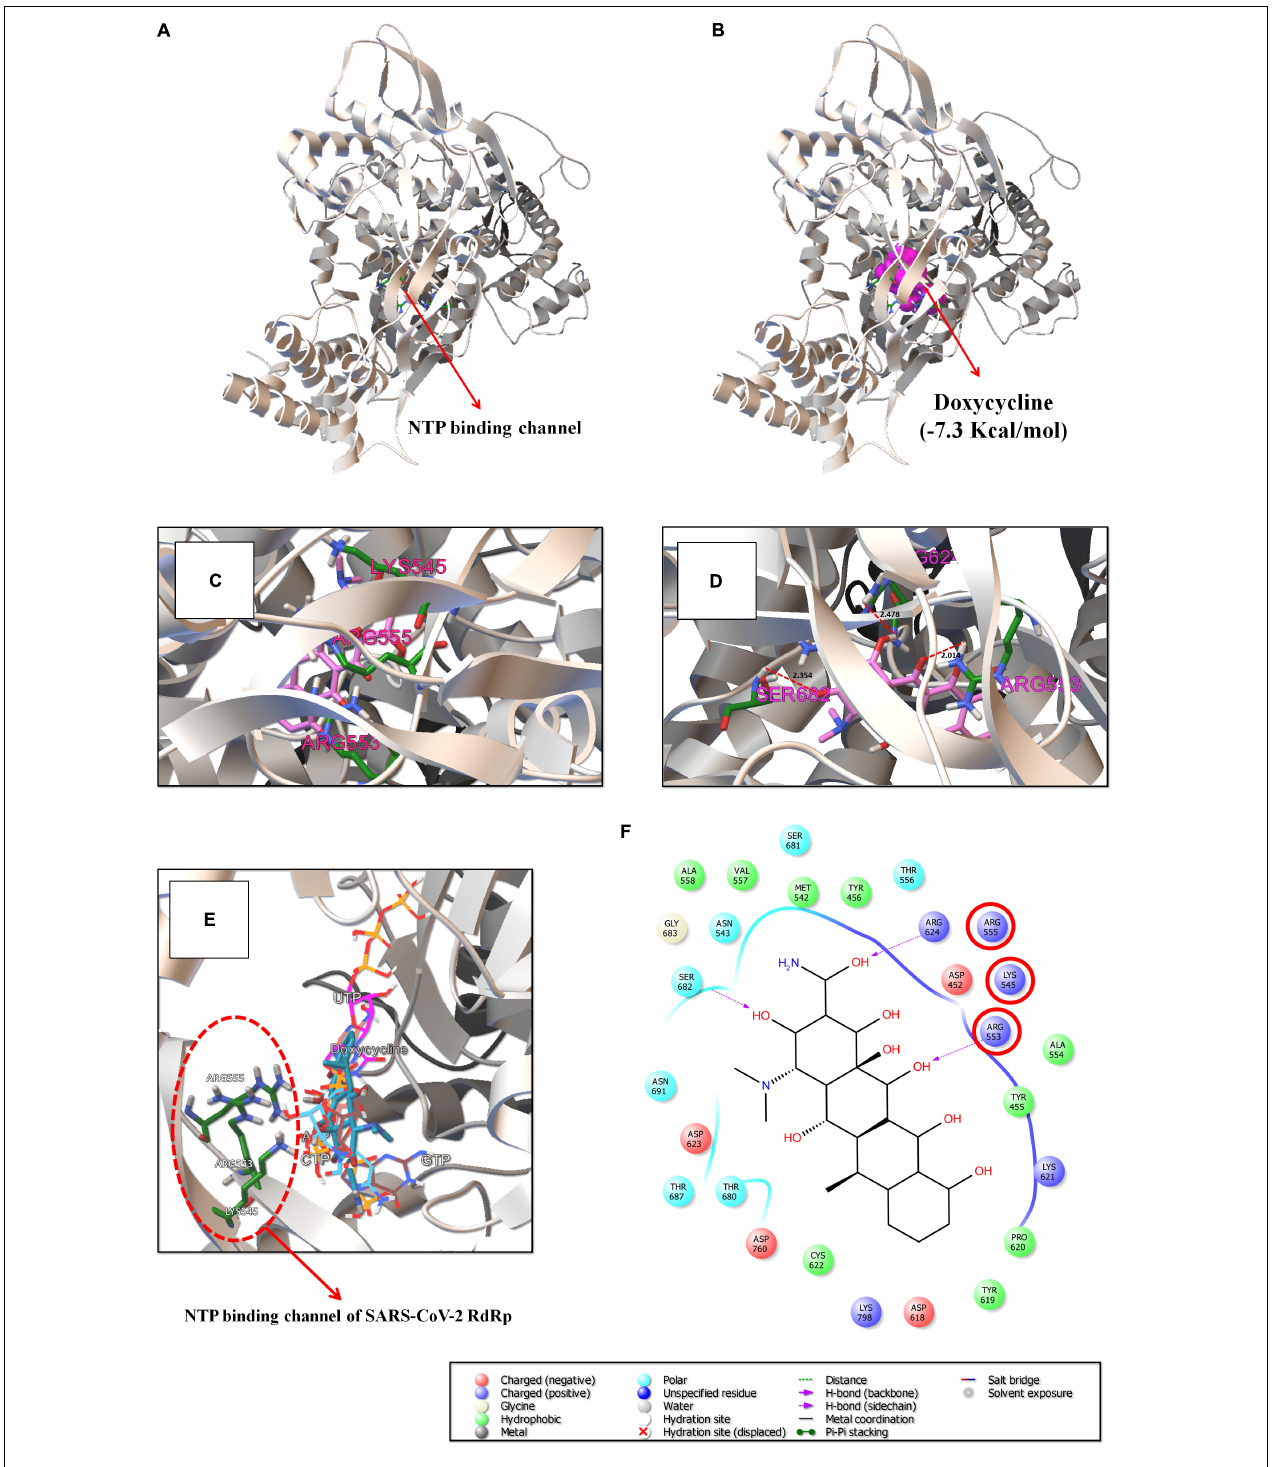
FIGURE 2 | Panel (A) shows the position of the NTP binding channel of SARS-CoV-2 (set of hydrophilic residues such as Lys545, Arg553, and Arg555). Panels (B,C) indicate the overview and close-up view of the binding interaction of doxycycline (–7.3 Kcal/mol) with the NTP binding channel of SARS-CoV-2. Panel (D) indicates the hydrogen bond formation of doxycycline with Arg553, Arg624, and Ser682 residues of SARS-CoV-2 RdRp at 2.014 Å, 2.478 Å, and 2.354 Å distances. Panel (E) indicates the antagonistic action of doxycycline on the binding sites of the parental-nucleotides of SARS-CoV-2 RdRp. Panel (F) demonstrates the interacted amino acid residues of SARS-CoV-2 RdRp with